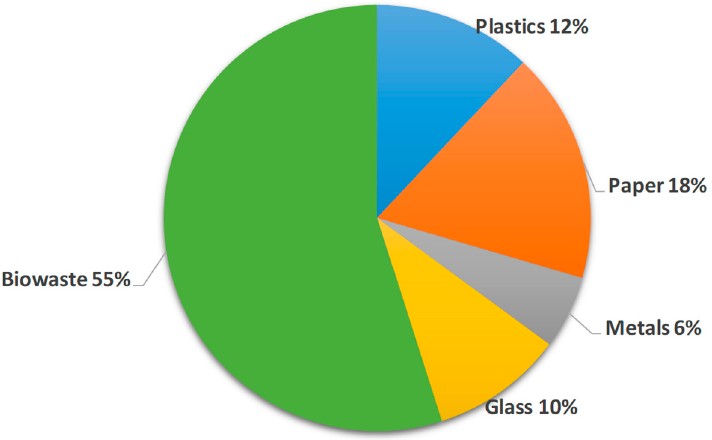
Figure 3. Reference composition for the functional unit of the study. Adapted from: W-MySir [7].